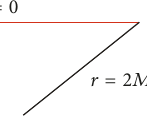
Figure 2: Diagram of the near-horizon